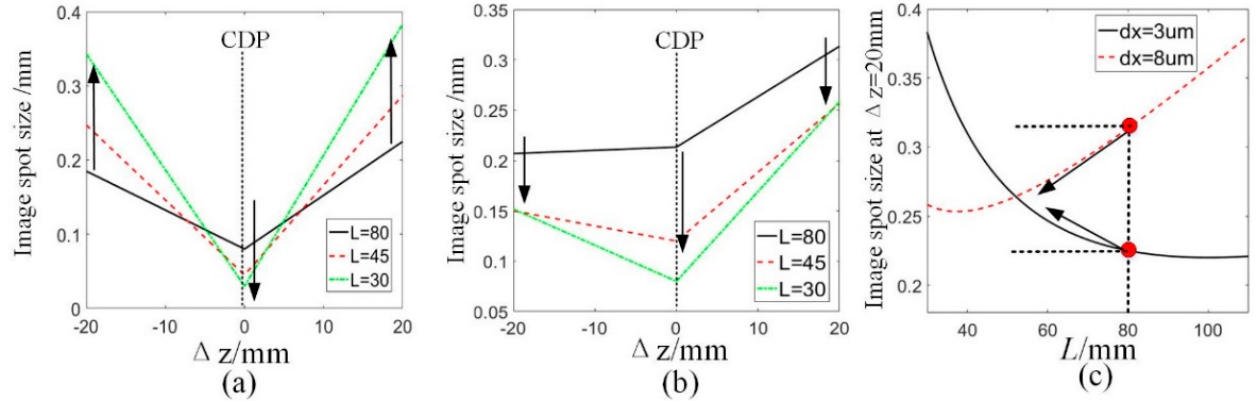
Figure 4. The relationship between image spot size S and defocused depth ∆ z at different capturing depth L , with ( a ) ∆ x 1 = 3 µ m and ( b ) ∆ x 1 = 8 µ m. ( c ) The relationship between L and image spot size at ∆ z = 20